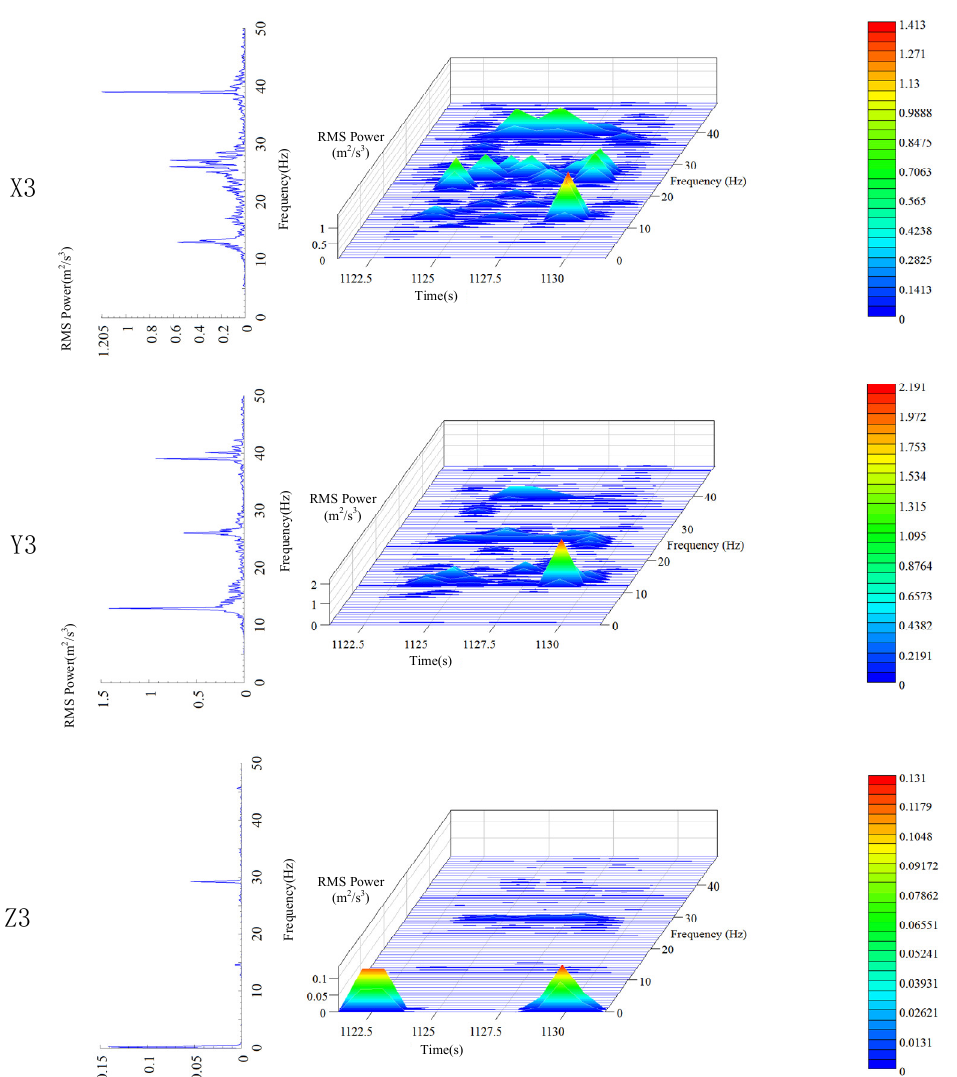
Figure 10. Time-frequency characteristics of hoist rope.